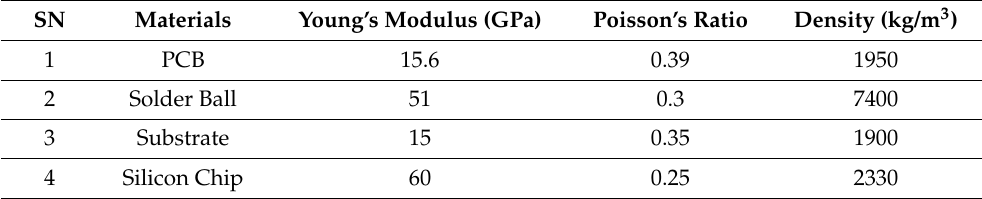
Figure 4. Local cut model after meshing. Table 1. Material Properties used in Finite Element Analysis.